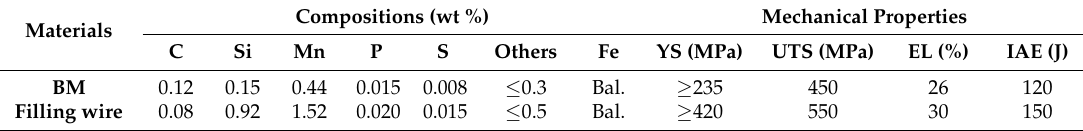
Figure 1. Schematic diagram of groove dimension (side view) and experimental setup (front view), where D is distance between beam center and wire tip, Δ f is focal point position, α is angle of arc torch to workpiece surface, CTWD is distance between contact tube and workpiece. Table 1. Nominal chemical compositions and mechanical properties of the base material (BM) and tensile strength, EL is total elongation, and impact absorbing energy (IAE) is impact absorbing energy.